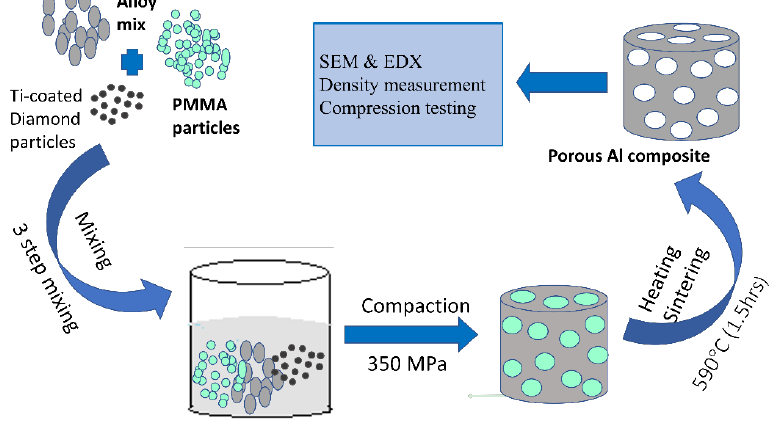
Figure 1. Fabrication process of porous Al composites.